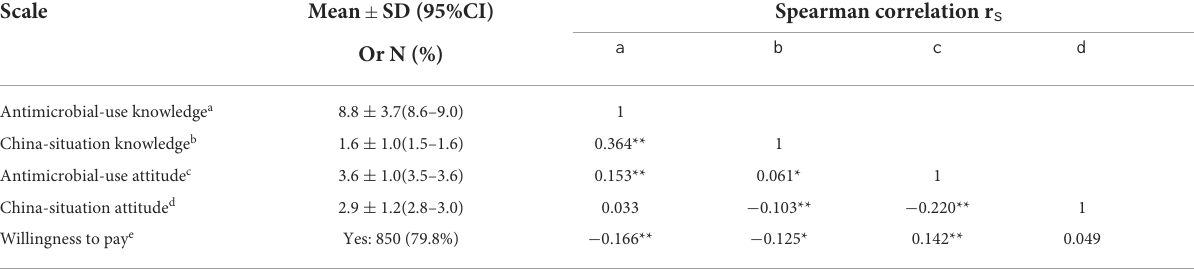
TABLE 2 Spearman correlation between knowledge, attitudes, and